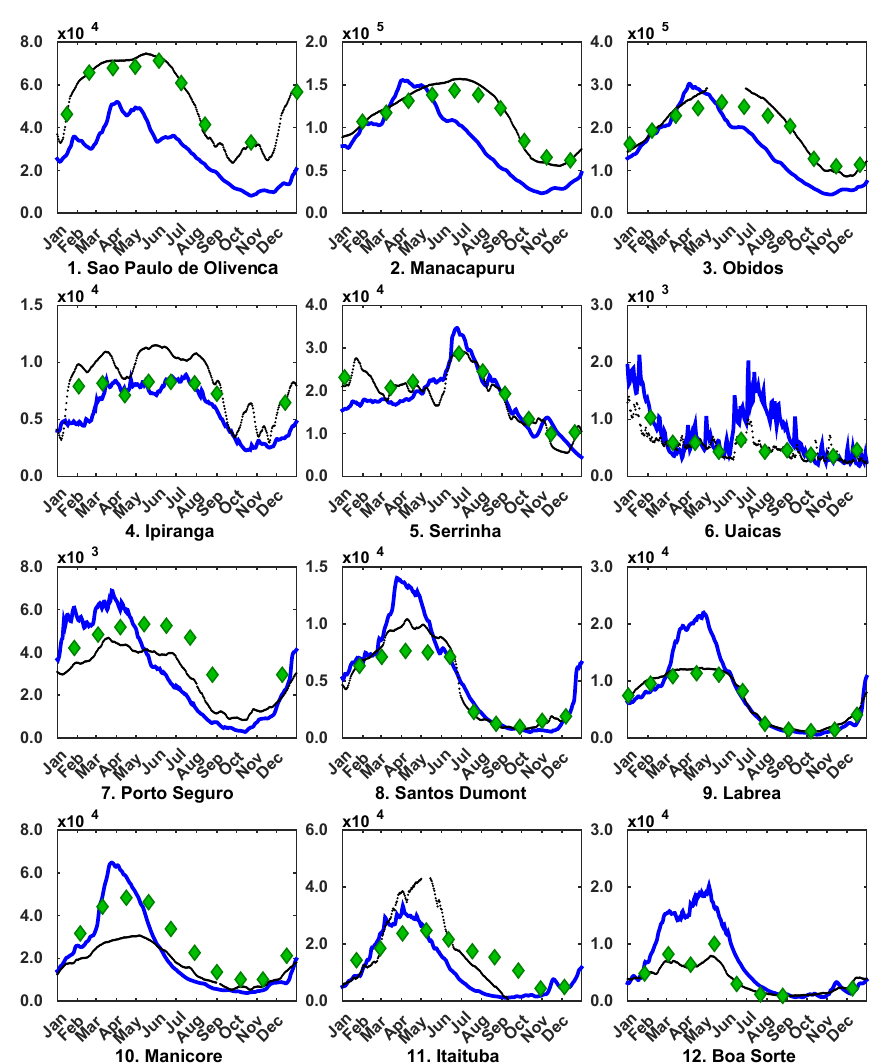
Figure 5. Comparison between the ISBA-CTRIP free run (blue line), ENVISAT-derived observed discharges (green markers) and ANA gauge discharges (black dots) over the year 2009. For each panel, the x -axis represents time (in days) and the y -axis represents discharge (in m 3 s − 1